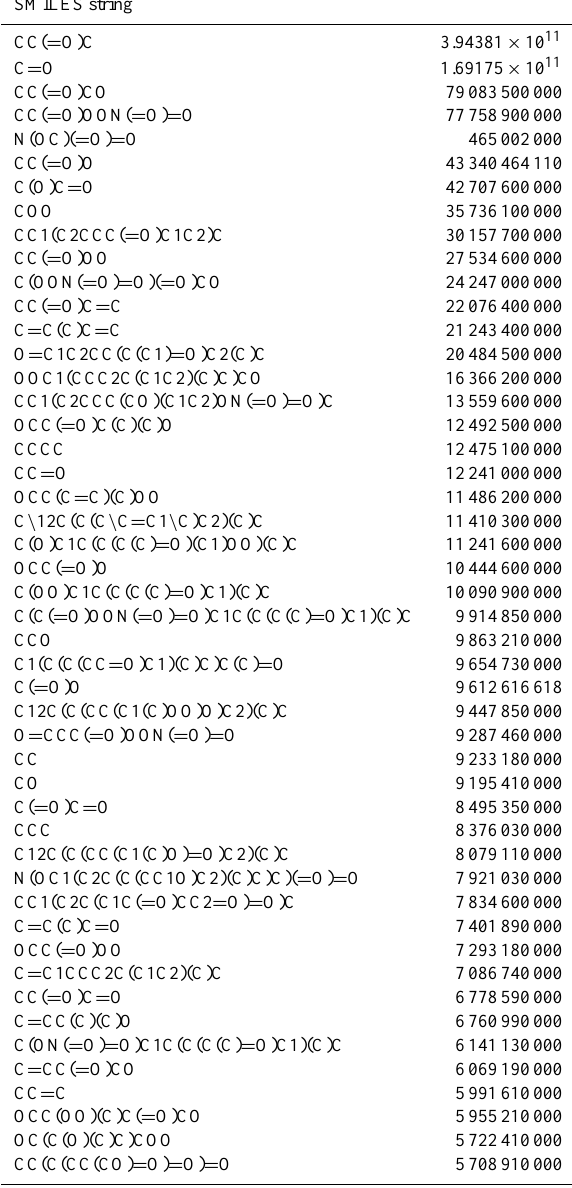
Table A2. SMILES strings and molecular abundance used for the partitioning predictions presented in Sect. 3.2. To replicate the re- sults, copy and past both SMILES and abundance information into a text file and following the procedures outlined in the main body of text. Please ensure there is space between a given SMILES string and the abundance. Please note that all exponential expressions need to be converted to numerical expressions; see the Supplement for further